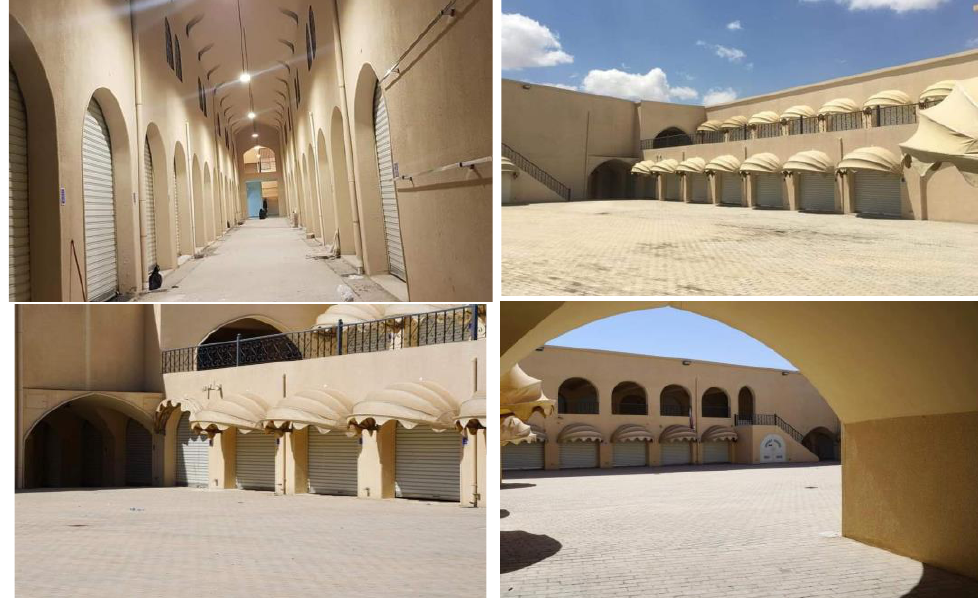
Figure 10. The reconstruction stage of Khan Hamo Qaddo. (photo credit: Nineveh Governorate and the Municipality of Mosul, Department of Media) [28].